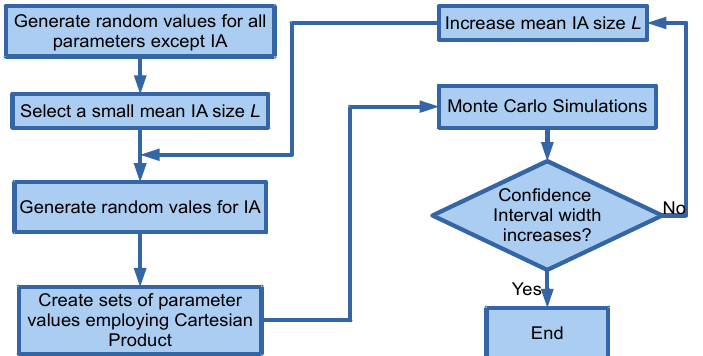
Figure 1. Schematic representation of Monte Carlo simulations to obtain the optimum mean IA size.